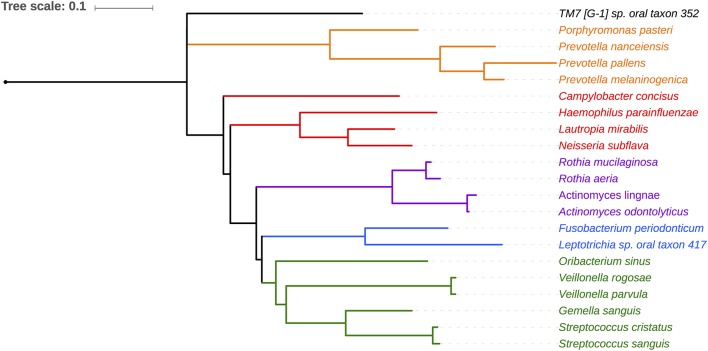
Phylogenetic relationship of 21 species shared by 80% of the subjects. Phylotypes assigned to single HOMD entity are shown. Five phylotypes assigned to multiple species are not shown (Granulicatella multispecies spp49 2, Streptococcus, multispecies spp1 2, Streptococcus multispecies spp24 14, Streptococcus multispecies spp32 2).